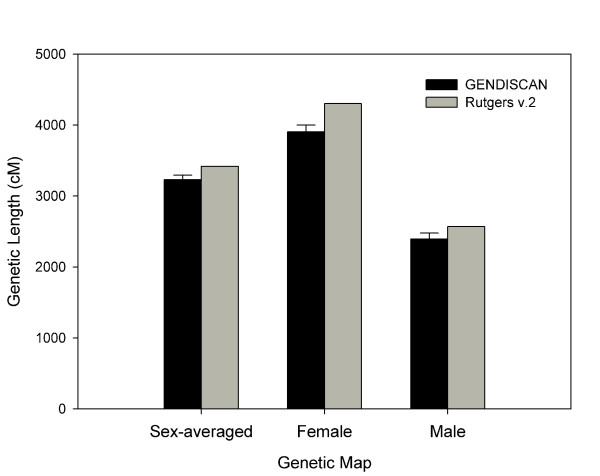
Comparison of whole genome lengths between the GENDISCAN map and Rutgers Map v.2. Error bars represents the 95% confidence intervals from the paired t-tests.